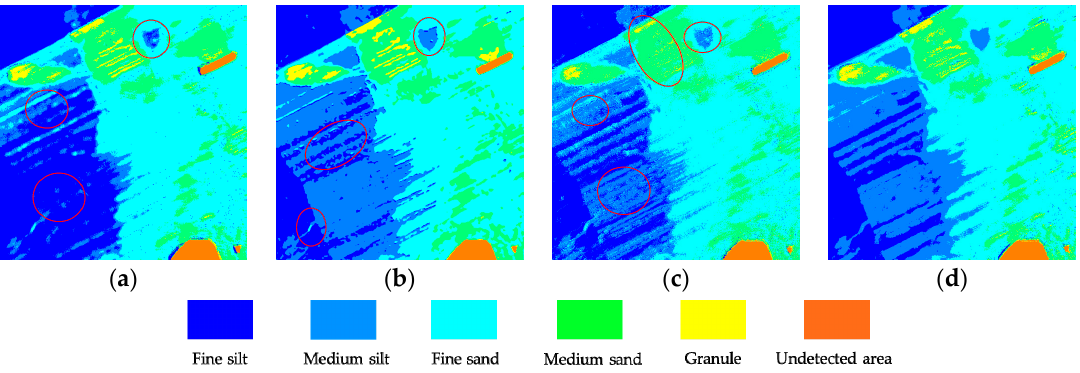
Figure 7. Image classification results of various feature extraction approaches in the Z1 area: ( a ) Gabor, ( b ) convolutional neural network (CNN), ( c ) stacked auto encoder (SAE), and ( d ) SDAE.